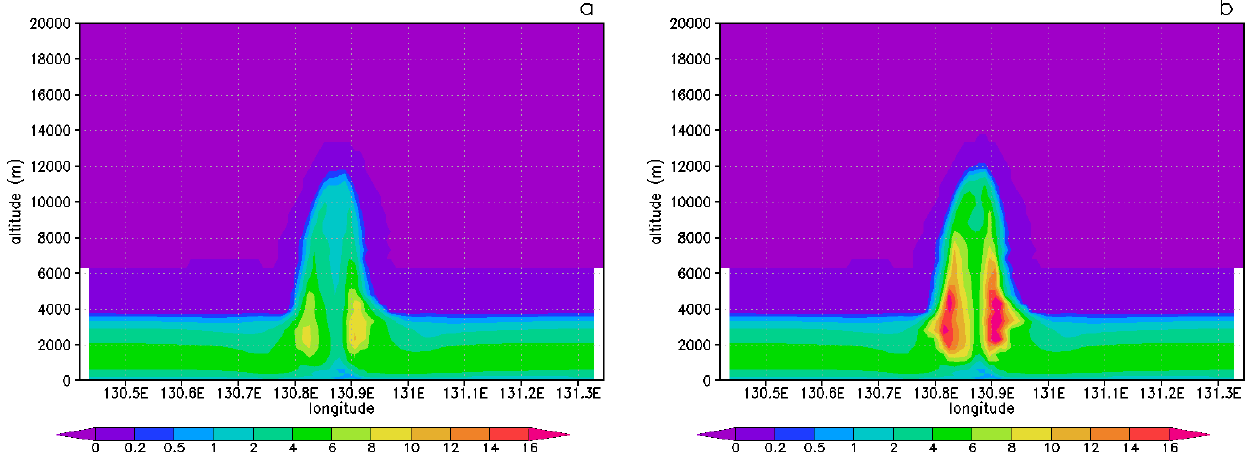
Fig. 9. Longitude-altitude cross section at 12.4 ◦ S at t 0 + 20min from the PERT1 simulation of Br x = Br+BrO+ 2 · Br 2 +HOBr in pptv for Figure 9: Longitude-altitude cross section at 12.4° S at t (a) cloud pH = 5 and (b) cloud pH = 4. = Br+BrO + 2*Br Br +HOBr in pptv for a) cloud pH = 5 and b) cloud pH = 4. x 2